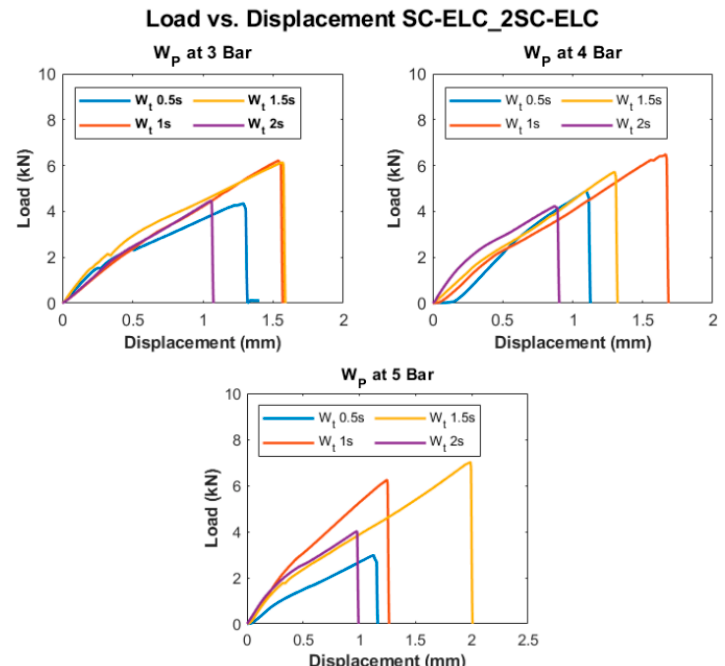
Materials 2018 , 11 , x FOR PEER REVIEW 12 of 27 Figure 10. Load vs. Displacement curves of SC-ELC_2SC-ELC configuration at different welding conditions.